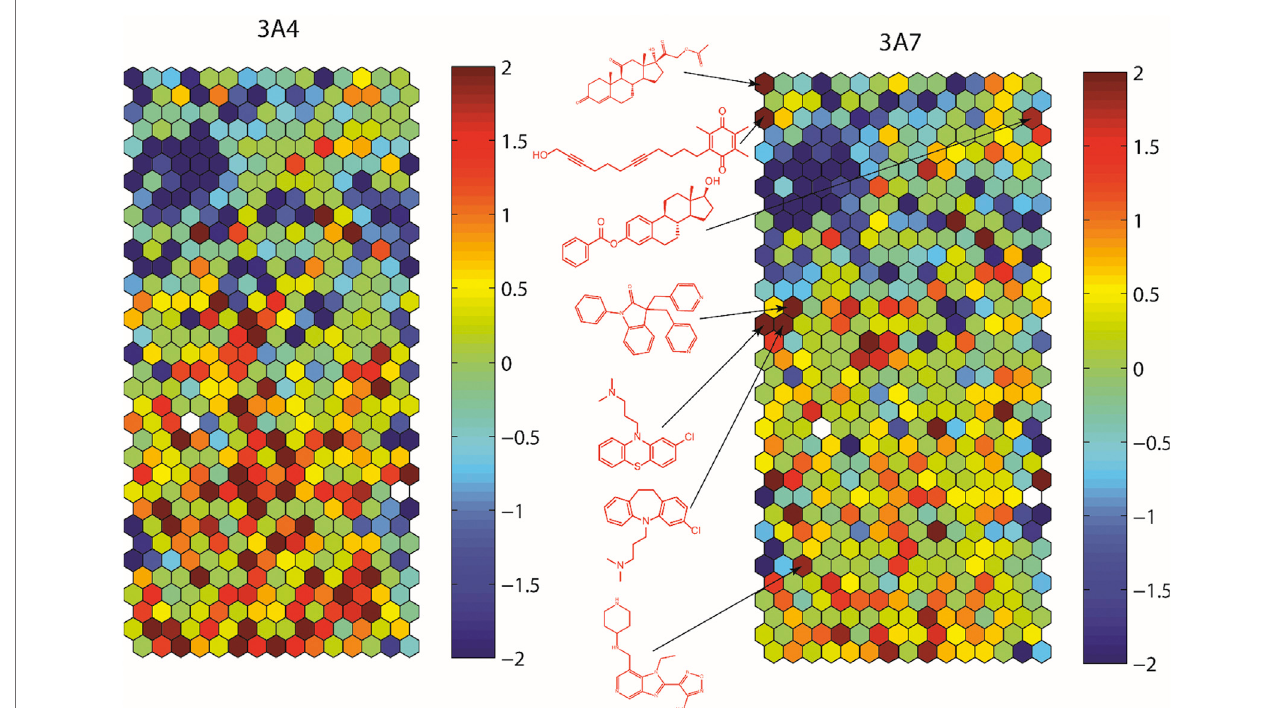
FIGURE 3 | Results of structure clustering of activity of compounds screened in CYP3A4 or CYP3A7. In the heat maps, each hexagon represents a cluster of compounds with structural similarity. Red colored clusters represent structures enriched with active compounds and blue colored clusters represent structures with minimal active compounds. Coloring is scaled by the negative log10 of the p -values. Compound structures show the examples of known drug groups active against CYP3A4 or CYP3A7 supersomes.